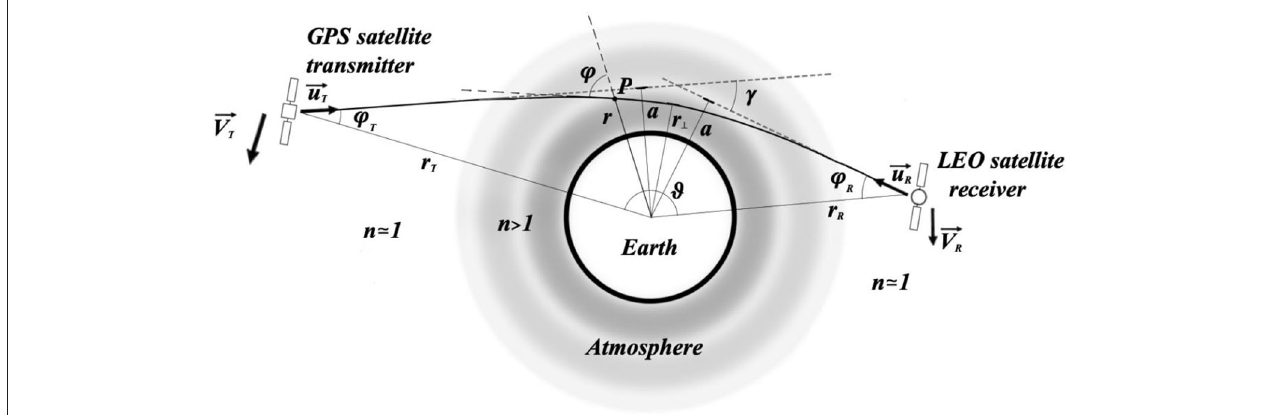
FIGURE 1 | Graphical representation of a RO observation. A radio signal path starting from the GPS transmitter T deviates from the straight line by a BA γ toward the LEO receiver R, due to the refraction of the atmosphere. Impact parameter is denoted by a , whereas ϕ is the incident angle of the ray line on the spherical surface of constant refraction index n . BA γ and impact parameter a are estimated by Doppler shifts measurements of the carrier frequency, if satellites positions and velocities, respectively −→ V T , −→ V R , and −→ r T , −→ r R , are